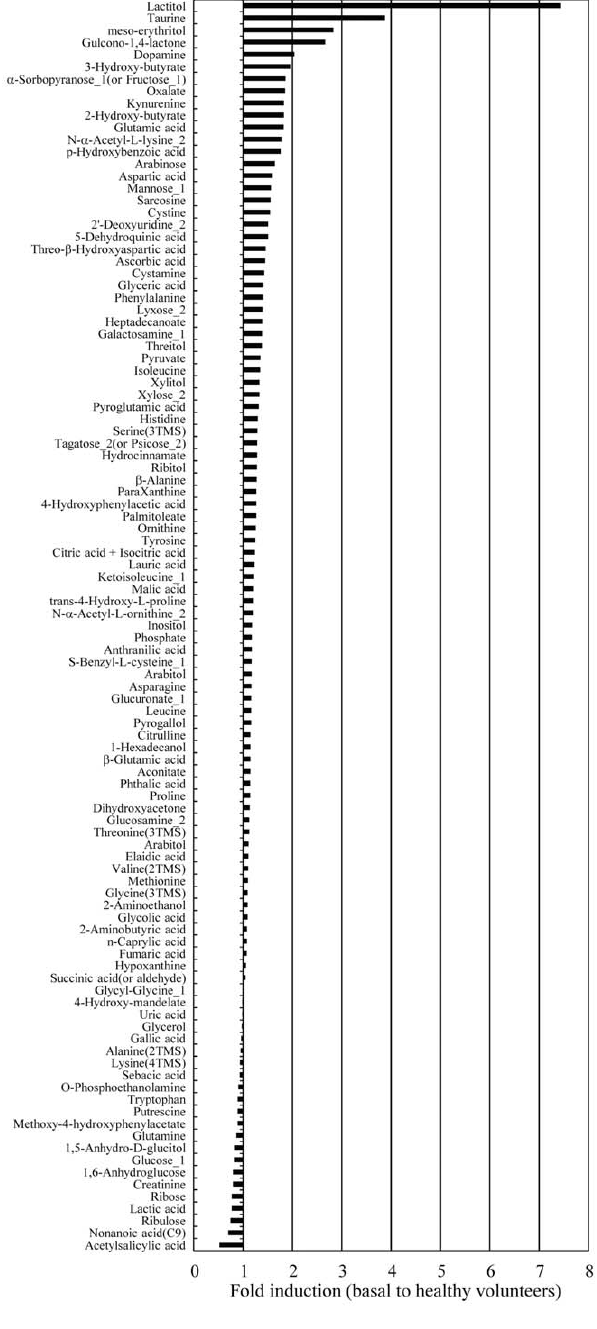
Figure 1. Comparison of serum metabolite levels between colorectal cancer patients and healthy volunteers. The mean fold changes in the levels of 107 metabolites observed in a comparison between colorectal cancer patients (N=60) and healthy volunteers (N=60) (training set) are shown in Figure 1. In GC/MS analysis, multiple peaks are sometimes detected for a particular metabolite due to TMS- derivatization, isomeric form, etc. In such cases, the peak that most reflected the level of the metabolite was adopted for the subsequent evaluation. In addition, each metabolite had the term ‘_1’, ‘_2’, or ‘(- TMS)’ added to the end of its name, as described in a previous report [7]. This figure does not include background metabolites or minor peak- derived